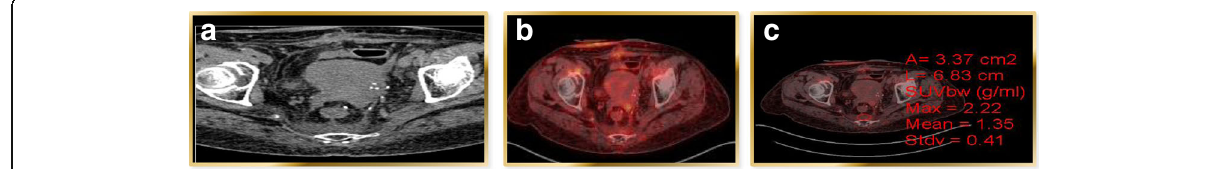
Fig. 2 a Post-operative CT study showing pre-sacral soft tissue density tumefaction. b PET/CT fused image with no appreciable FDG uptake within the post-operative fibrosis using the visual assessment method. c PET/CT fused image with SUV max of the lesion 2.2 with no suspicious areas of